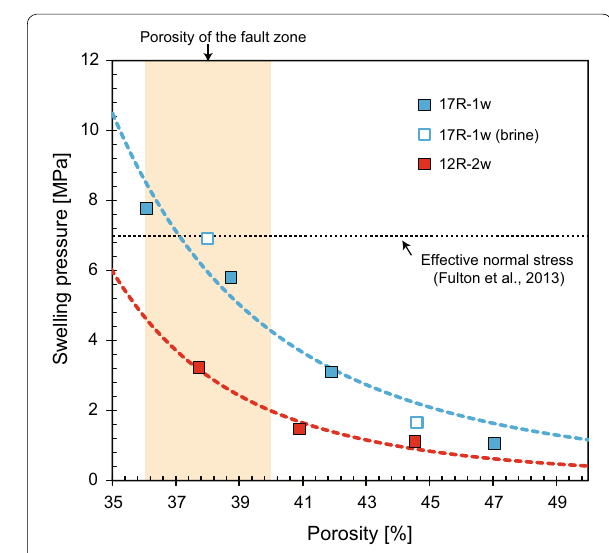
Fig. 3 Swelling pressure results for the JFAST samples. Swelling pressure results for the fault zone sample (solid blue squares for pure water and open squares for brine) and host rock sample (red squares) as a function of sample porosity. The data were fitted by the empirical equation of Hedin (2004) (blue and red dashed lines). Also shown are the in situ porosities of the fault zone deduced from logging data (Fig. 1b) and effective normal stress based on the fault’s depth, hydrostatic pore pressure, and measured rock densities (7 MPa; Fulton et al.